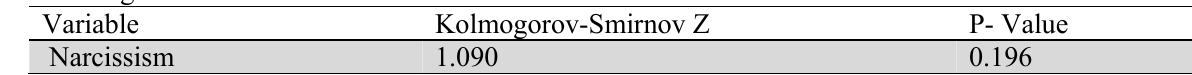
Kolmogorov–Smirnov test